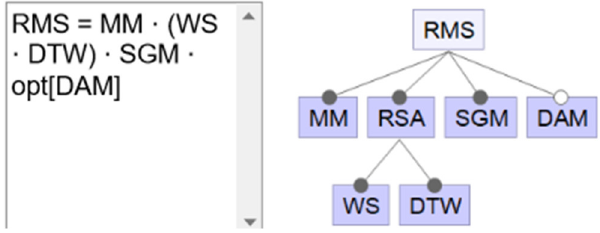
Figure 4. Initial feature of RMS.